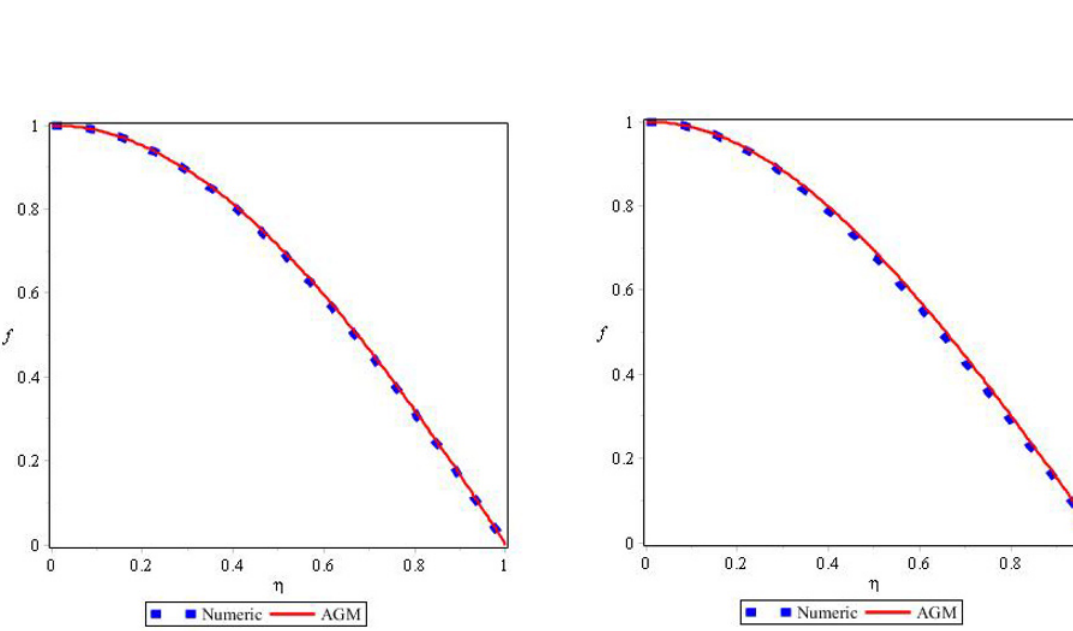
Figure 14. Comparison between the obtained solutions for f HPM and Numerical Method ( A ∗ = 1 , Ha = 0 , Re = 50 , α = 2 ◦ , φ = 0 ).